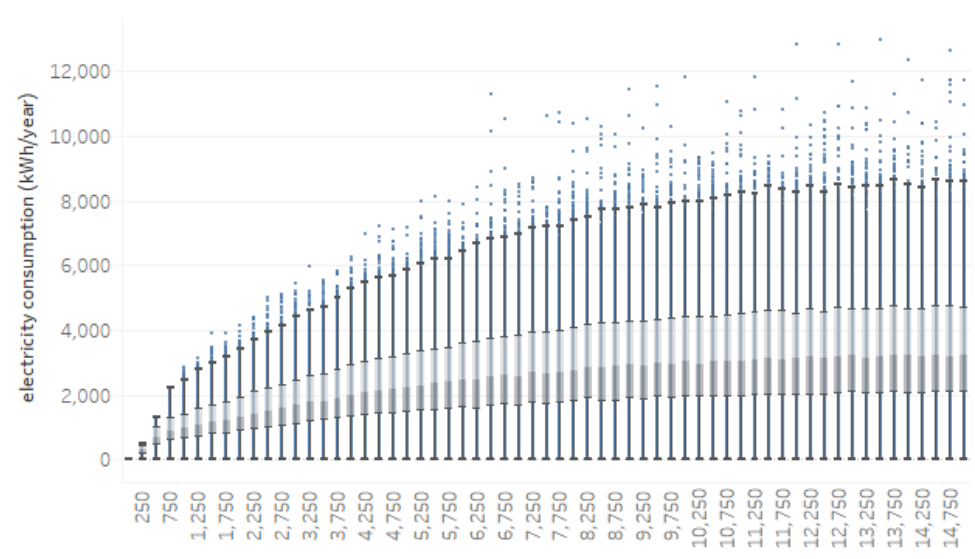
Figure 4. Relationship between annual household income and annual electricity